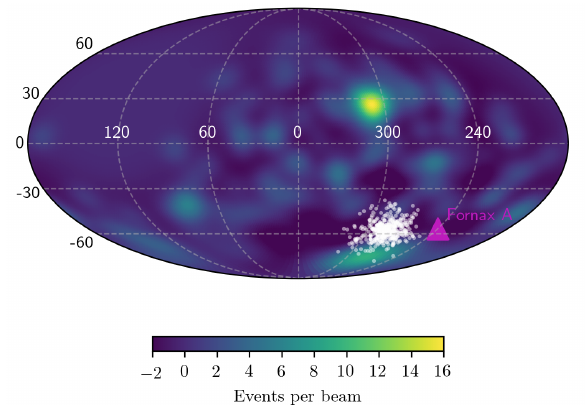
Figure 4: The observed excess map from A18 in Galactic coordinates for events with energies > 60 EeV, with the position of Fornax A overlaid. The projection is the same as A18 and the formulae are given in M18a. The white dots show the simulated directions of 10 EV CRs propa- gated from Fornax A through the Jansson & Farrah [50] Galactic magnetic field model as described in the